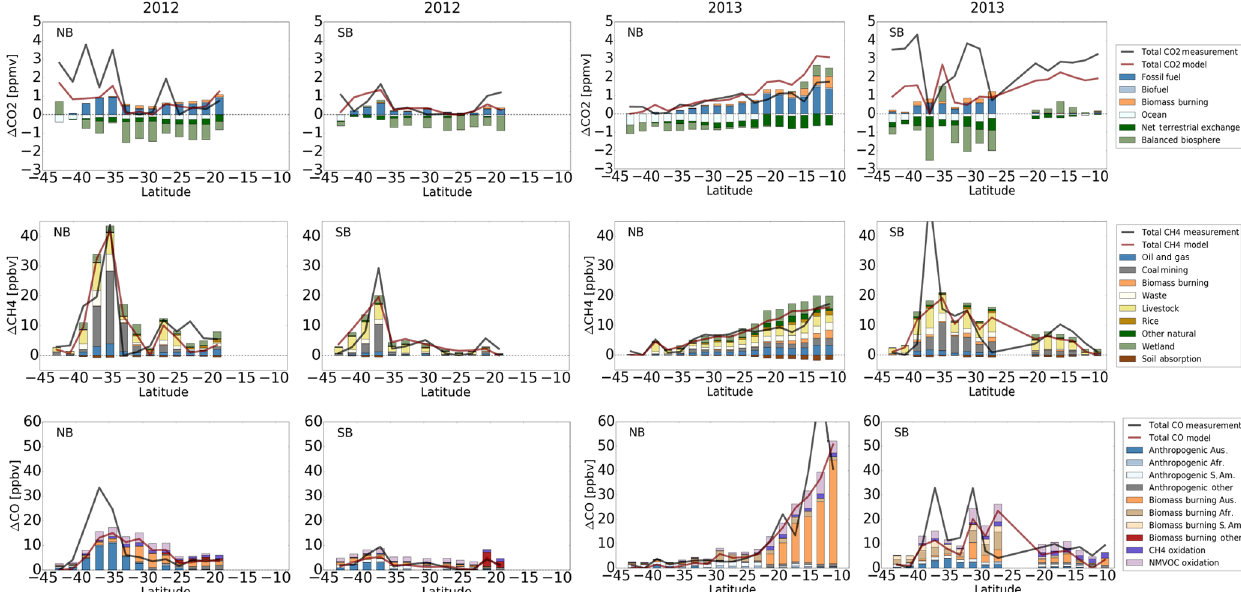
Figure 4. Measured (black) and modelled (red) CO 2 , CH 4 and CO latitudinal enhancements (lines) and modelled source contributions (stacked bars) in 2012 (left) and 2013 (right) for the northbound (NB) and southbound (SB) sections of the ship cruises. All the data were averaged in 2 ◦ latitude bands after the measurement–model averaging. The enhancements were calculated based on the difference between the individual 2 ◦ latitudinal values and the minimum value during each